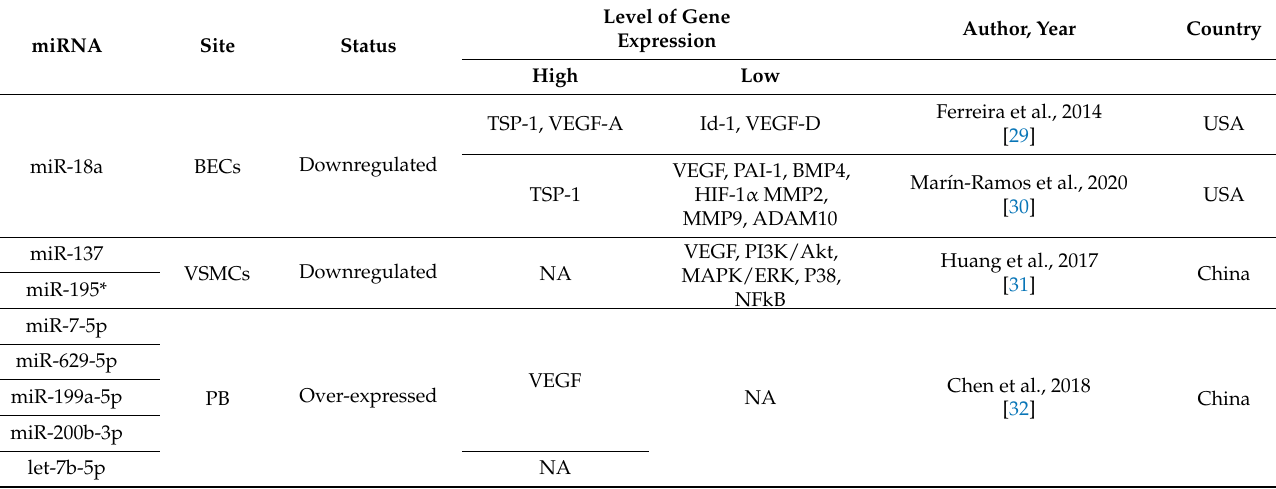
Table 1. Dysregulated microRNAs and direct target genes in brain arteriovenous malformations.